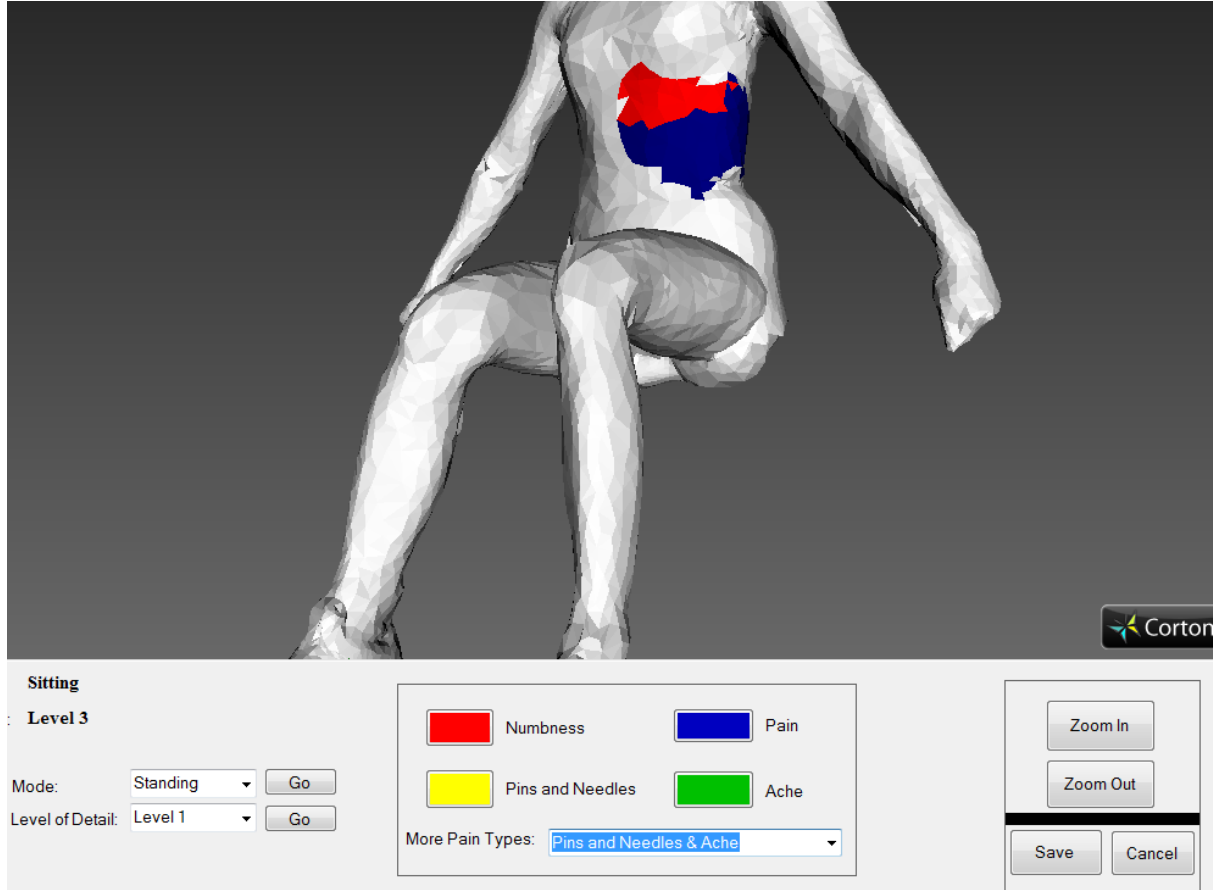
Figure 2. Example screenshot of the 3D pain drawing